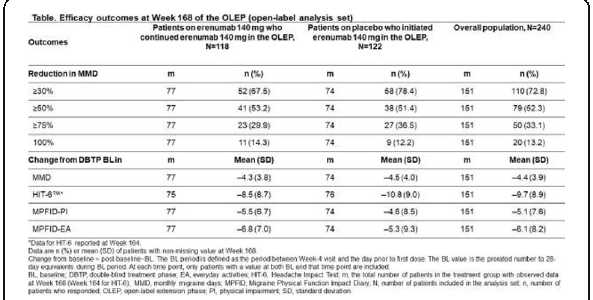
Fig. 1 (abstract P0475). See text for